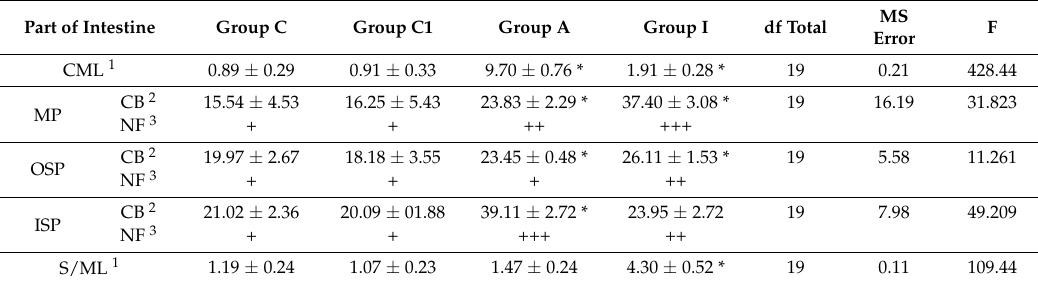
Table 1. CGRP-like immunoreactive (LI) perikarya and nerve fibers in the porcine descending colon under physiological conditions (Group C), after “sham” operation (Group C1), after axotomy (Group A) and during inflammation (Group